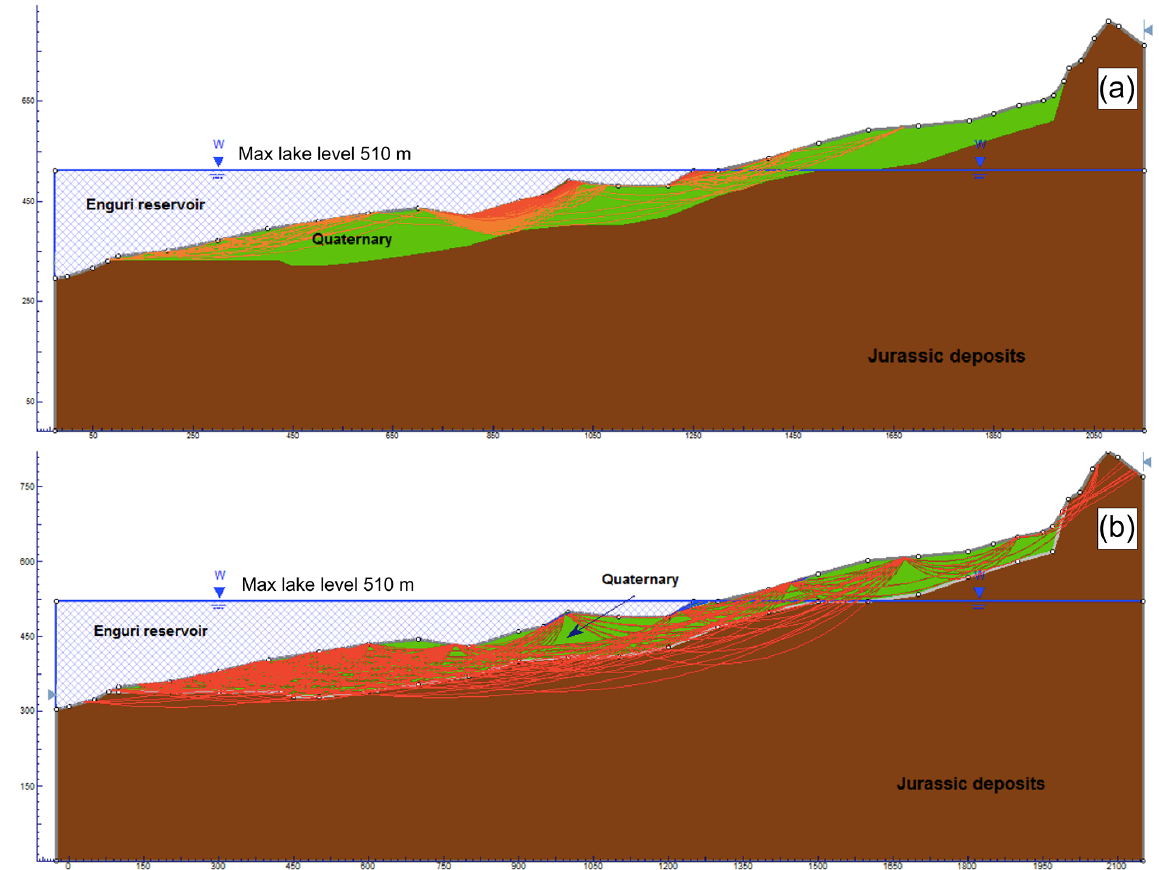
Figure 14. Results from seismic slope stability analysis. (a) Pseudostatic analysis showing the development of several potential slip surfaces (orange and red lines) with FS < 1. (b) Dynamic modeling, using a Newmark approach, showing the development of several large slip surfaces (red lines) that would experience more than 1m of displacement. Since 1m is considered a critical displacement that would yield failure, these slip surfaces indicate very unstable conditions along the slope in case of an earthquake producing the calculated local seismic